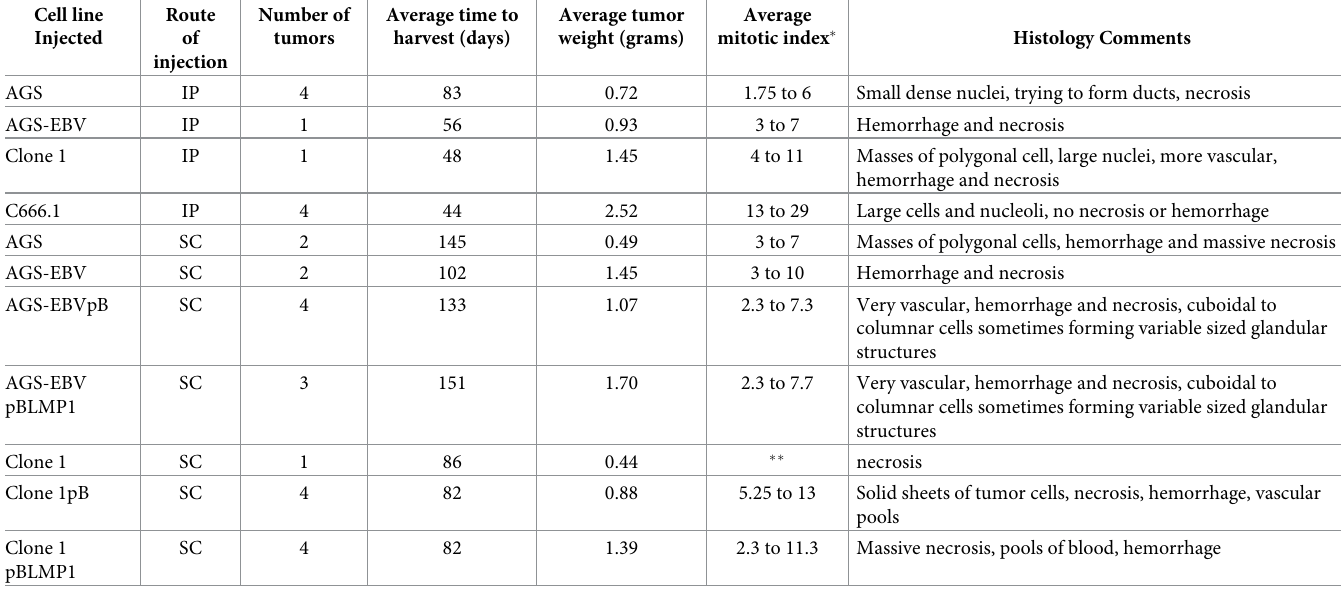
Table 1. Tumor samples and